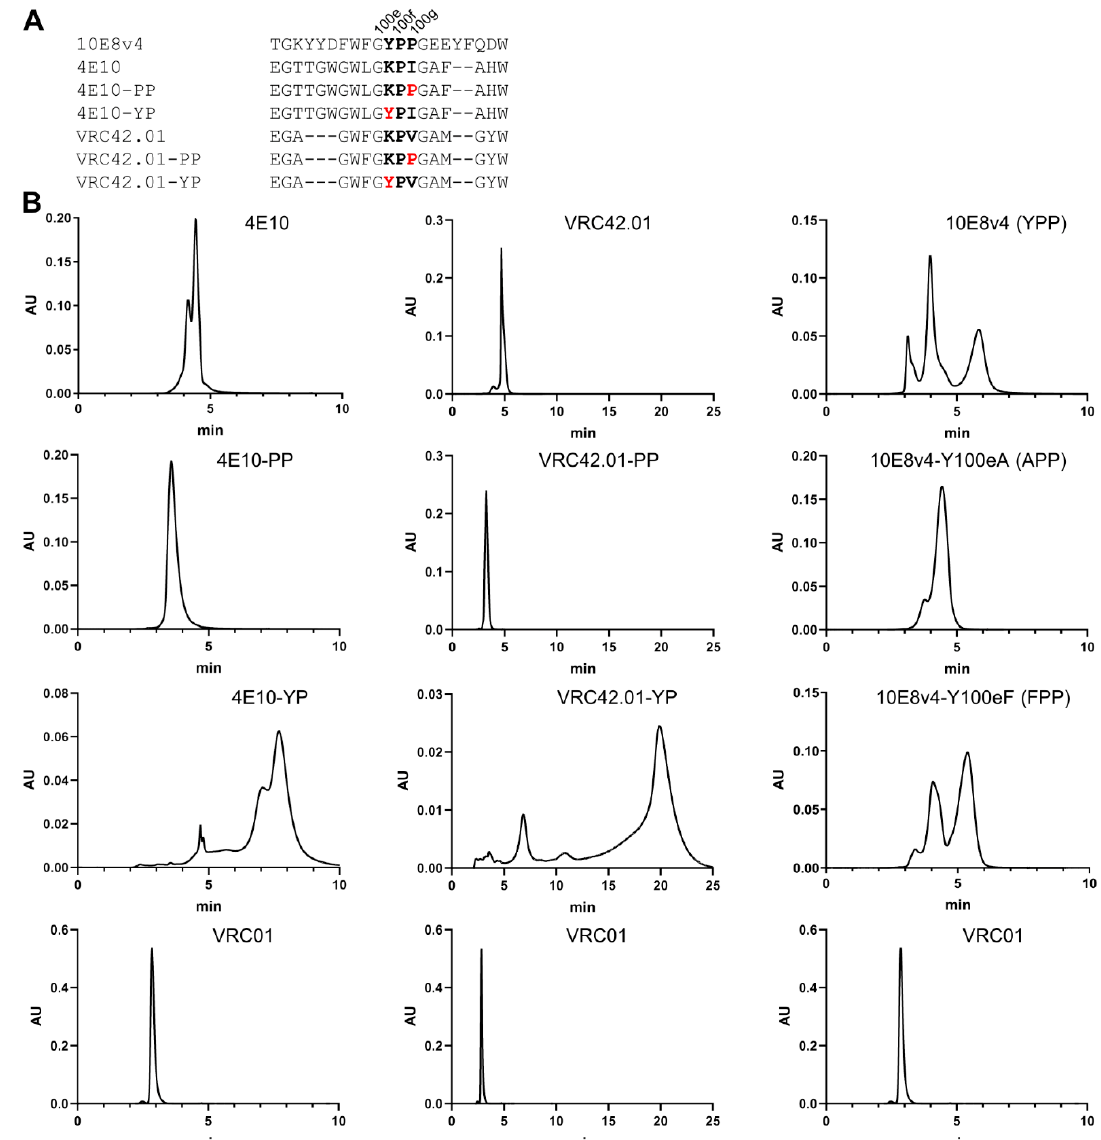
Figure 6. Tyr residues proceeding the Pro in the CDR H3s of antibodies 4E10 and VRC42.01 replicated the SEC anomaly observed with 10E8v4. ( A ) Aligned sequences of CDR H3s of 10E8v4, 4E10 and VRC42.01 variants. Substituted amino acids were highlighted in red. ( B ) SEC profiles of 4E10, VRC42.01 and 10E8v4 variants along with the SEC profile of VRC01 control.